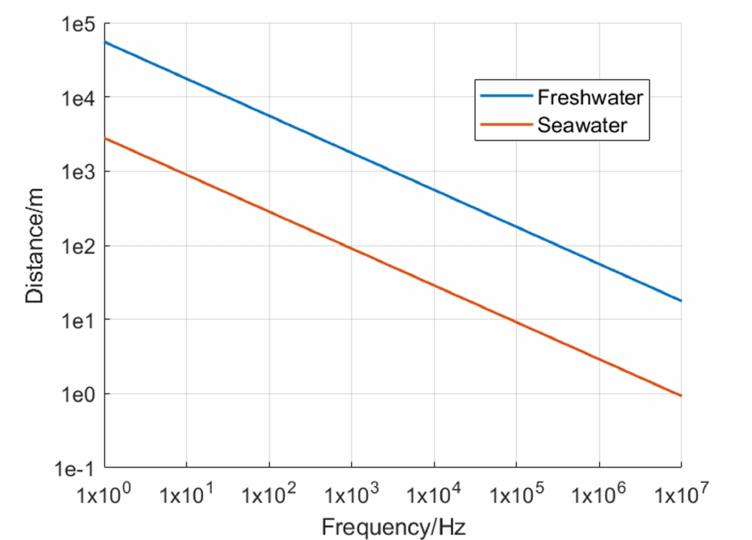
Figure 7. Impact of increasing frequency on propagation distance